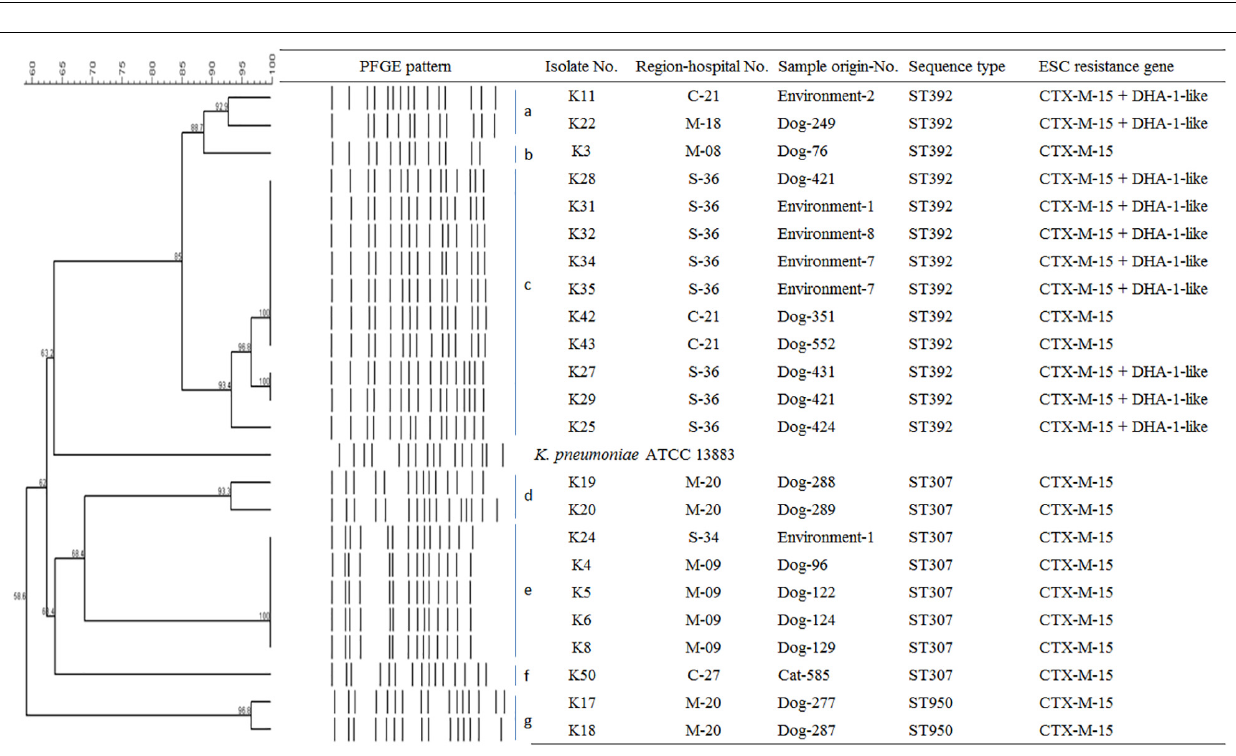
FIGURE 2 | Epidemiological profiles of 23 K. pneumoniae isolates carrying ESC resistance gene (CTX-M-15 and DHA-1-like) determined by PFGE analysis using Xba I restriction. Environment-1, examining table; Environment-2, cage; Environment-4, scale; Environment-7, keyboard; Environment-8, switch; M, metropolitan region; C, central region; S, southern